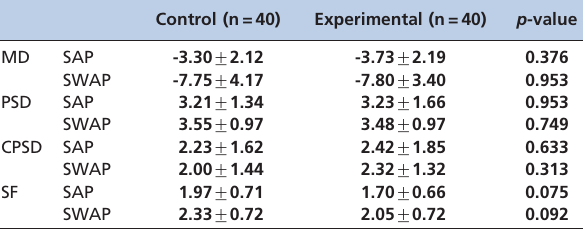
Table 2 - Visual parameters of patients in the experimental and control groups obtained via standard achromatic perimetry and short wavelength automated